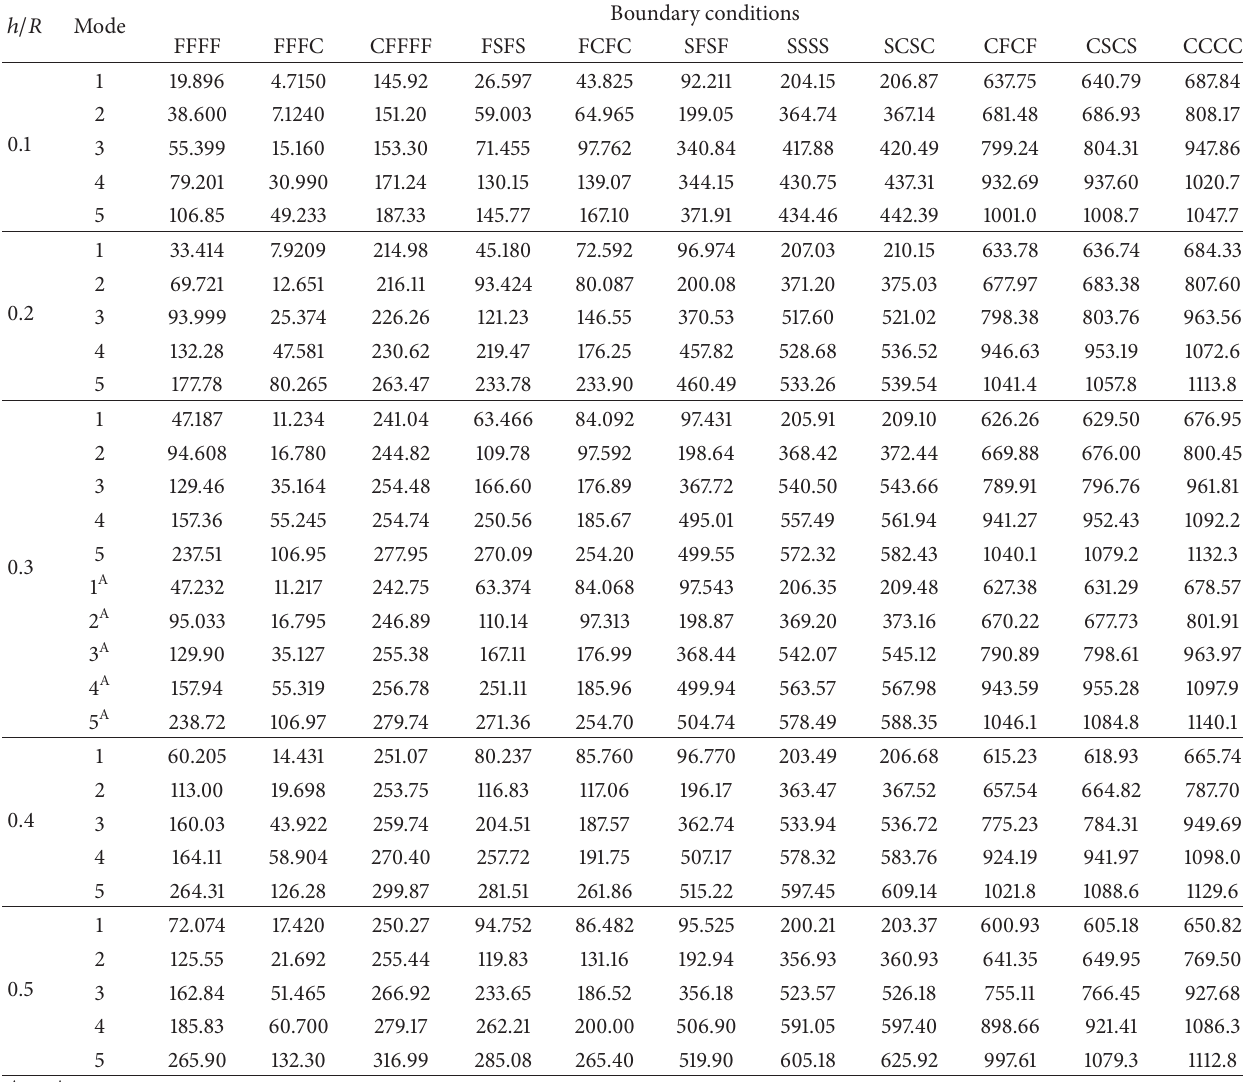
Table 15: The first five frequencies (Hz) of an open orthotropic spherical shell with various boundary conditions and thickness-radius ratios ( 𝜙 0 = 𝜋/4 , 𝜙 1 = 𝜋/2 , 𝑅 = 1 m, and 𝜃 0 = 𝜋 ).